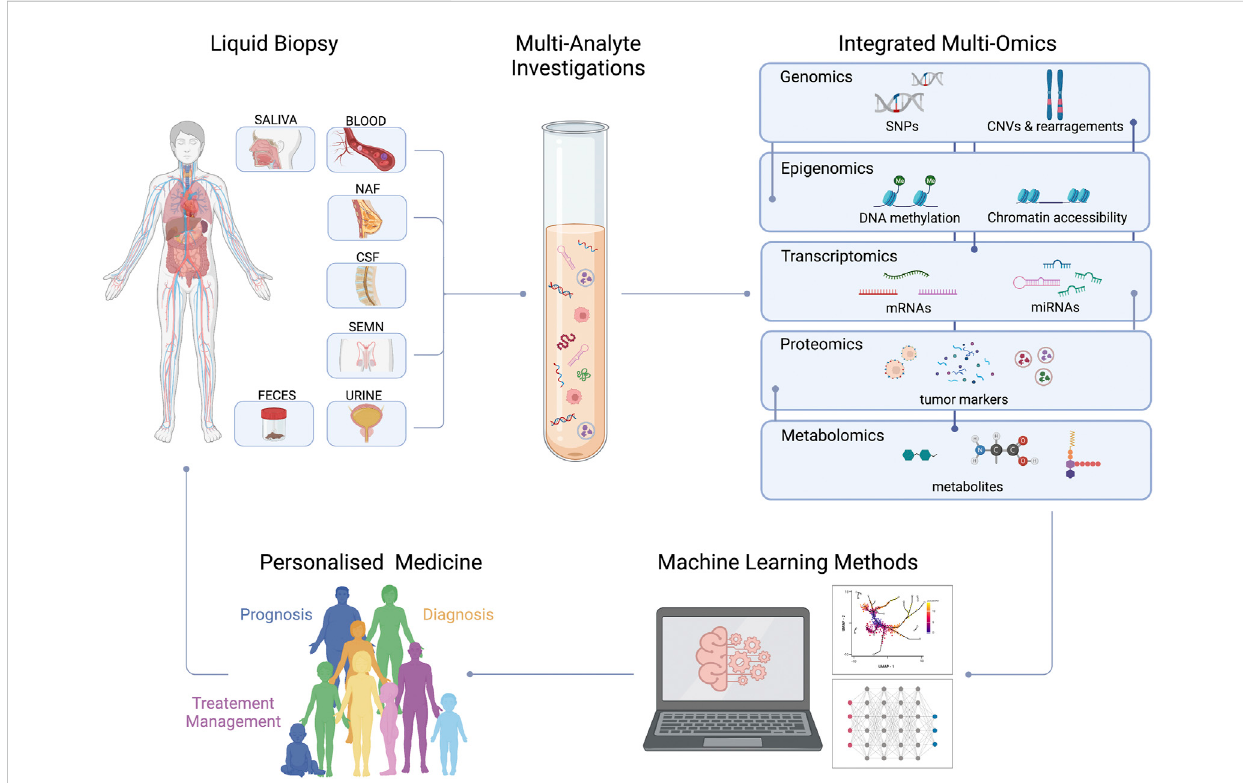
FIGURE 2 Integrated multi-omic approach in liquid biopsy. An integrated multi-omic approach is going to be used investigating single or multiple analytes from different fl uids of the same patient. Arti fi cial intelligence will be educated using the enormous amount of information that has been created. From the resulting predictive models can be originated personalized medical decisions (NAF, Nipple Aspirate Fluid; CSF,Cerebrospinal Fluid; SEMN, Seminal Fluid; CNV, Copy Number Variations; SNPs, Single Nucleotide